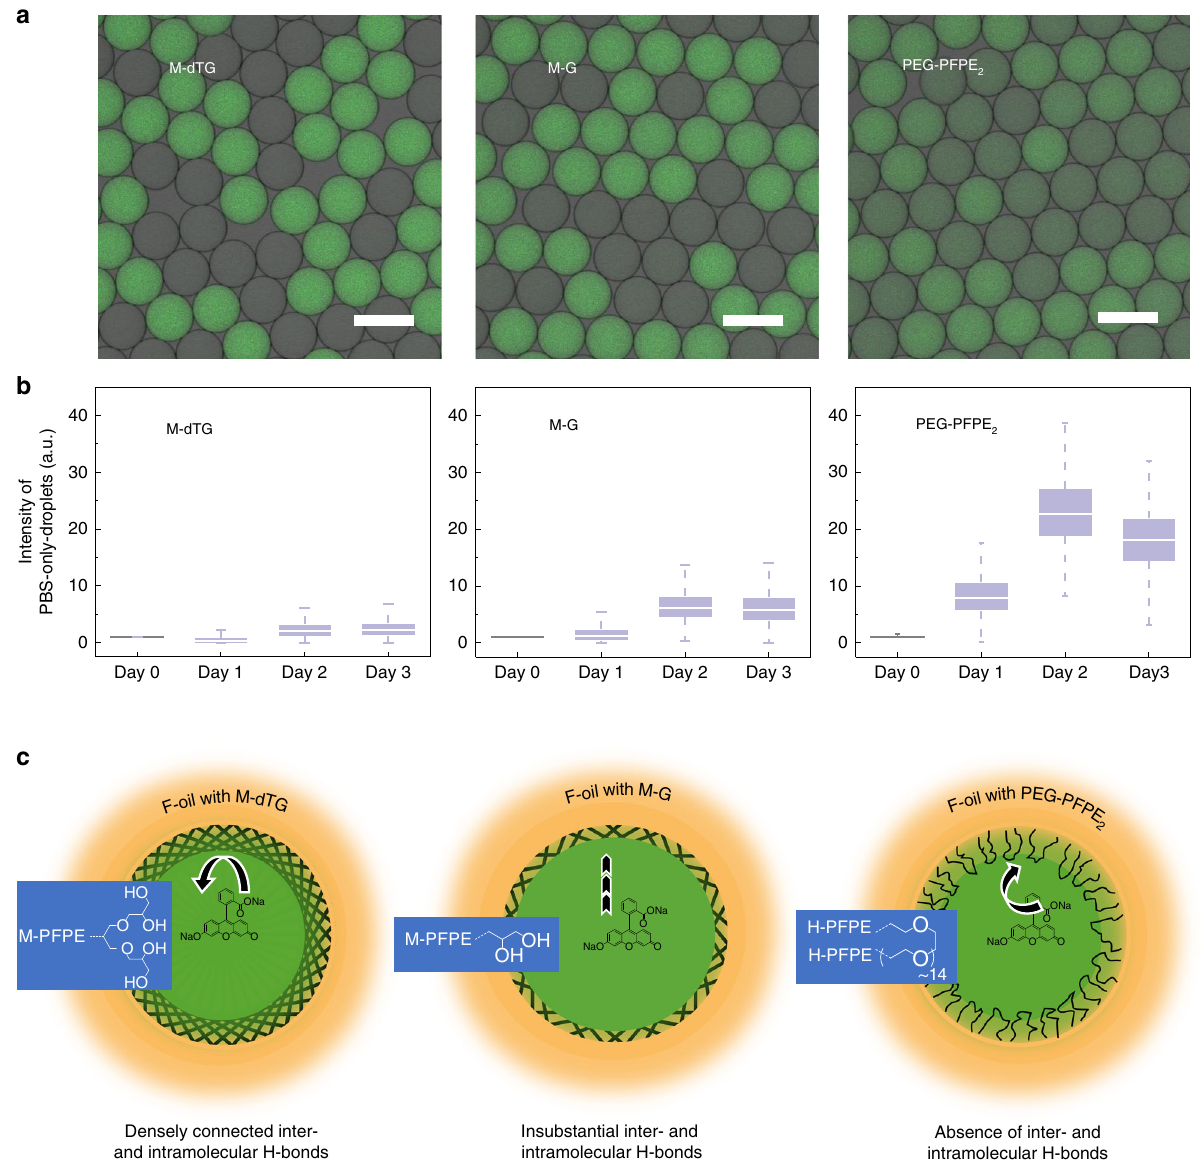
Fig. 3 In fl uence of dense hydrogen bond network on inter-droplet diffusion. a For each surfactant, we used parallel drop maker to create a mixture comprising equal amounts of PBS-only-droplets and PBS + sodium fl uorescein salt-containing droplets. Confocal fl uorescent imaging of droplets after 72 h incubation at 37 °C is shown in top panel. b We incubated these mixtures, took fl uorescence images at the indicated time points, and then performed quantitative analysis of the fl uorescence intensity of the 10 randomly selected PBS-only droplets. Box-plot demonstrates that dye was almost completely retained in droplets stabilized by M-dTG, while some transfer was detected in M-G droplets. PEG-PFPE 2 surfactant-stabilized droplets showed substantial transfer (left to right). The box plots represent the median (center line), the interquartile range (box) and the non-outlier range (whisker). c A model representing the plausible inter- and intramolecular hydrogen bonding from M-dTG, M-G, and PEG-PFPE 2 surfactants (left to right). The lines denote hydrogen bonding at the interface of oil and water. For PEG-PFPE 2 surfactant, as there is no hydrogen bond donor, there is no inter- and intramolecular hydrogen bond present. Scale bars = 100 µ m; a.u. = arbitrary units. Source data of Fig. 3b (middle panel) are provided as a Source Data fi